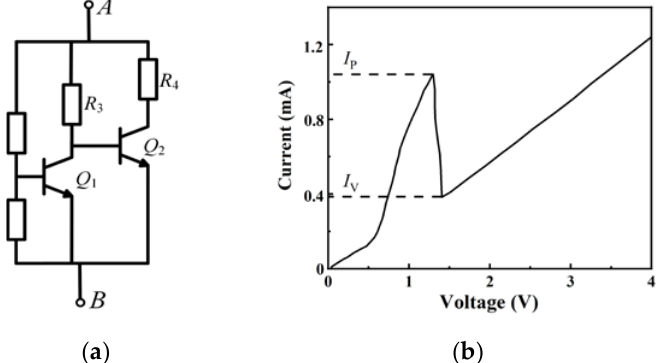
Figure 1. R-HBT-NDR unit and its i - v characteristic curve: ( a ) R-HBT-NDR unit, ( b ) the i - v charac- teristic curve of R-HBT-NDR unit.